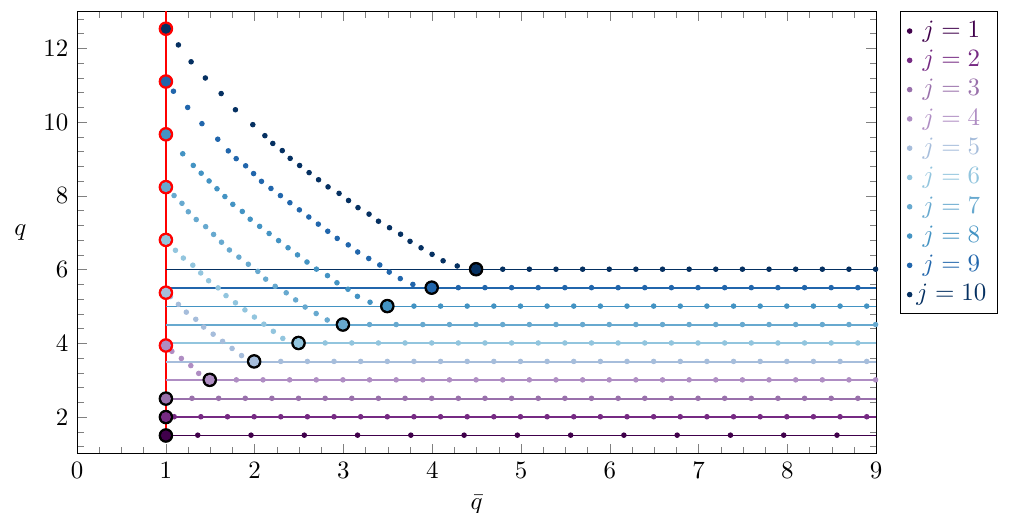
Figure 1 . Lower bounds on the conformal dimension as a result of the ANEC for long multiples. Each point is the result of a bisection algorithm done with sdpb [23] (see section 5.4). The solid lines are the unitarity bound: the red line is the bound on (cid:22) q and the colored lines are the j -dependent bounds on q . The larger dots correspond to the points with shortening conditions [ L; A 2 ] (for the red circled dots) and [ A 1 ; L ] (for the black circled dots).